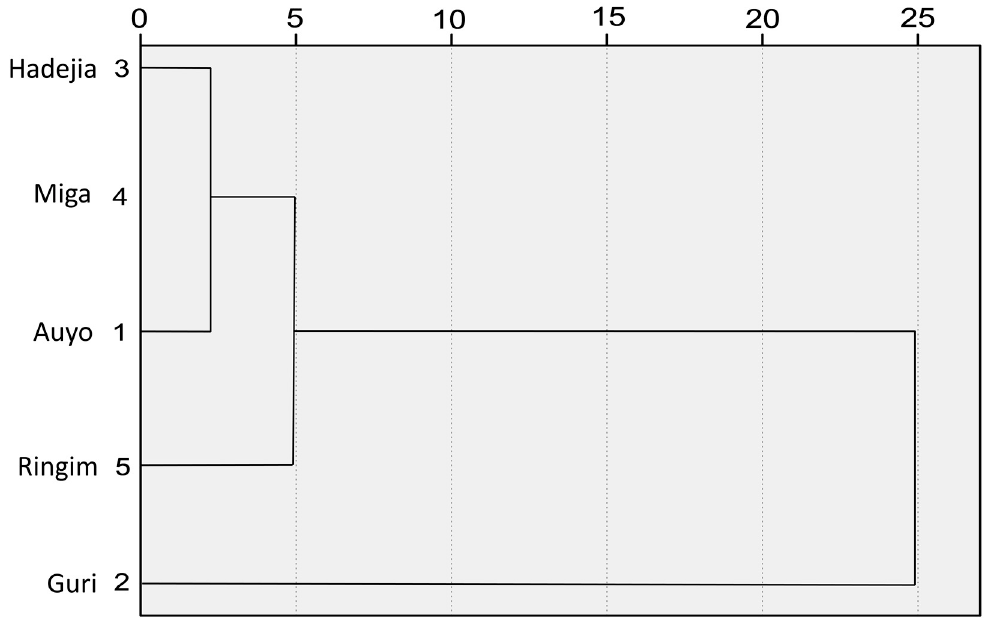
Figure 7. Dendrogram showing the cluster of sampling sites based on the groundwater dynamic levels along the basin.